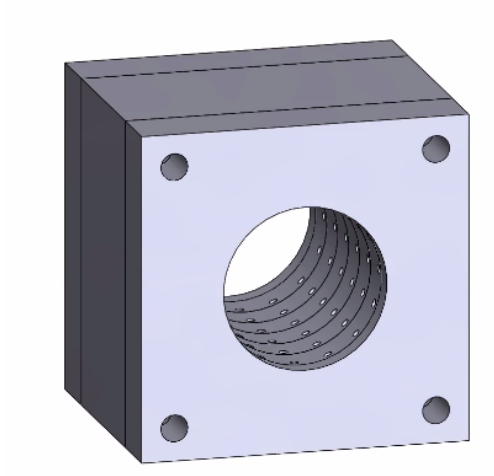
Figure 7. DENORMS cylinder cavity grazing incident testing.